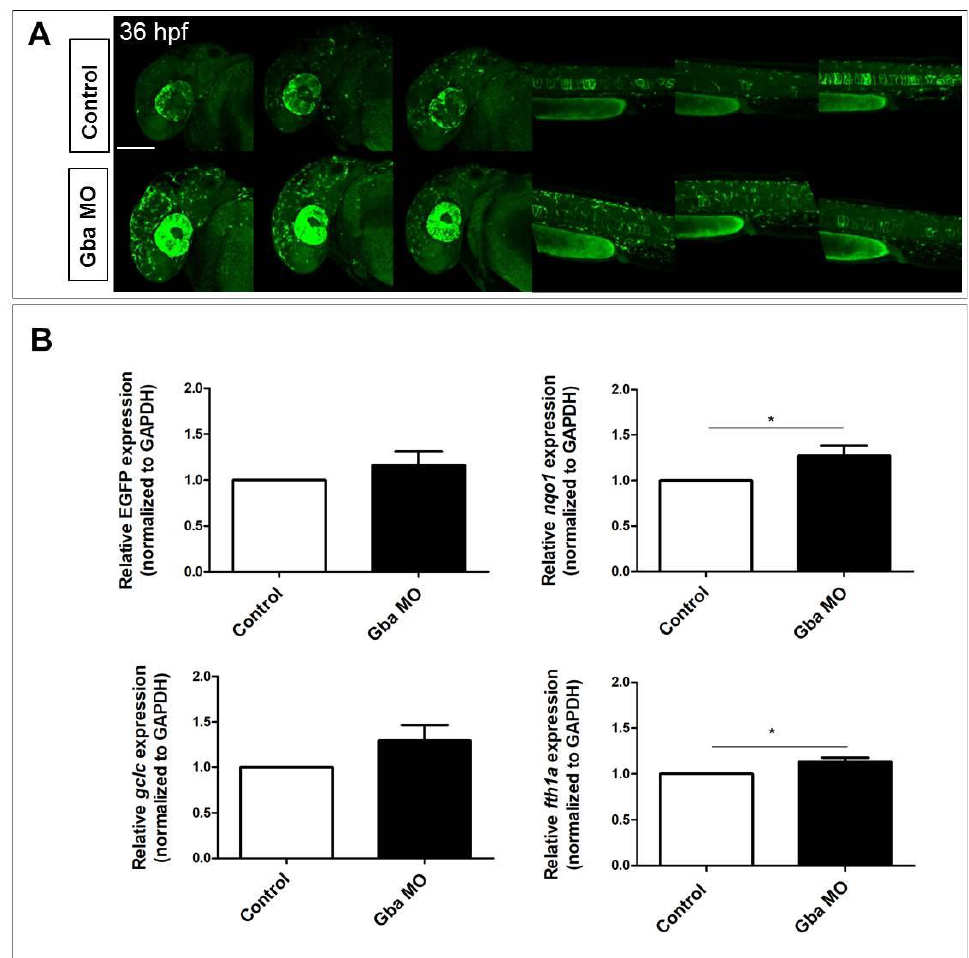
Figure 4. Beta glucocerebrosidase knockdown does not significantly increase Nrf2/ARE reporter expression but does induce the upregulation of Nrf2-pathway-related targets. ( A ) Confocal Z-stack projections of 30 hpf control and Gba1 morphant fish, showing increased reporter expression in both cephalic and caudal regions of morphants. For comparison, three different morphant and control fish are depicted. All images are lateral view with anterior to the left. Scale bar: 100 µ m. ( B ) Bar graphs showing the quantitative EGFP reporter and Nrf2 pathway-related genes expression measured in morphant and control fish RNA extracts. Data are mean ± SD of three independent biological replicates (each replicate consists of ten larvae per condition; * p < 0.05; t -test).